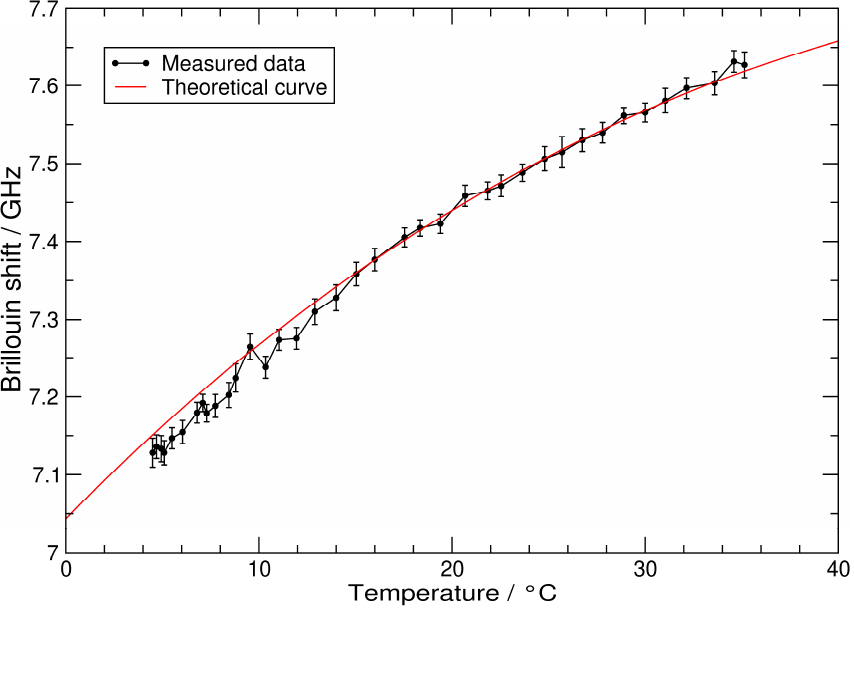
Figure 5. Measurement of the frequency shift versus the water temperature. The red curve indicates the theoretical frequency shift at zero salinity after Fry et al.